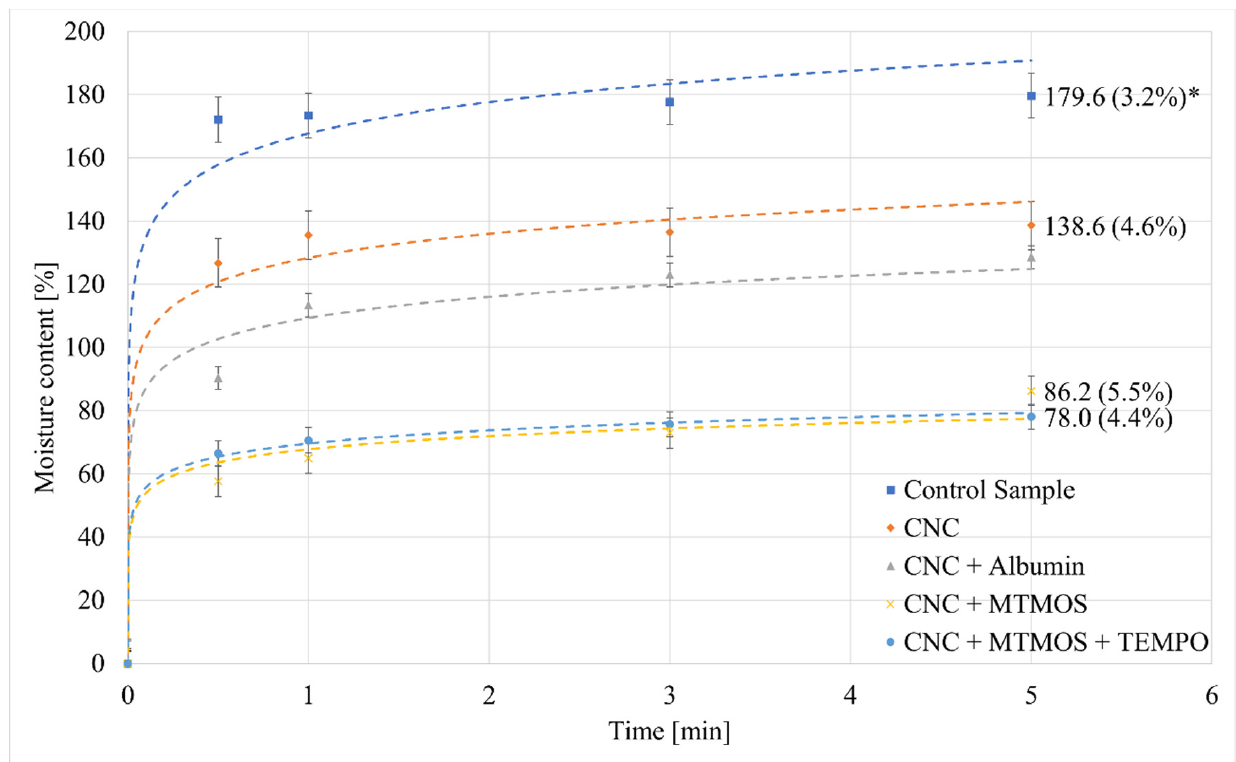
Figure 5. Water absorption (%) of tested CNC samples. * The relative standard deviation (RSD) (%) values are shown in parentheses.